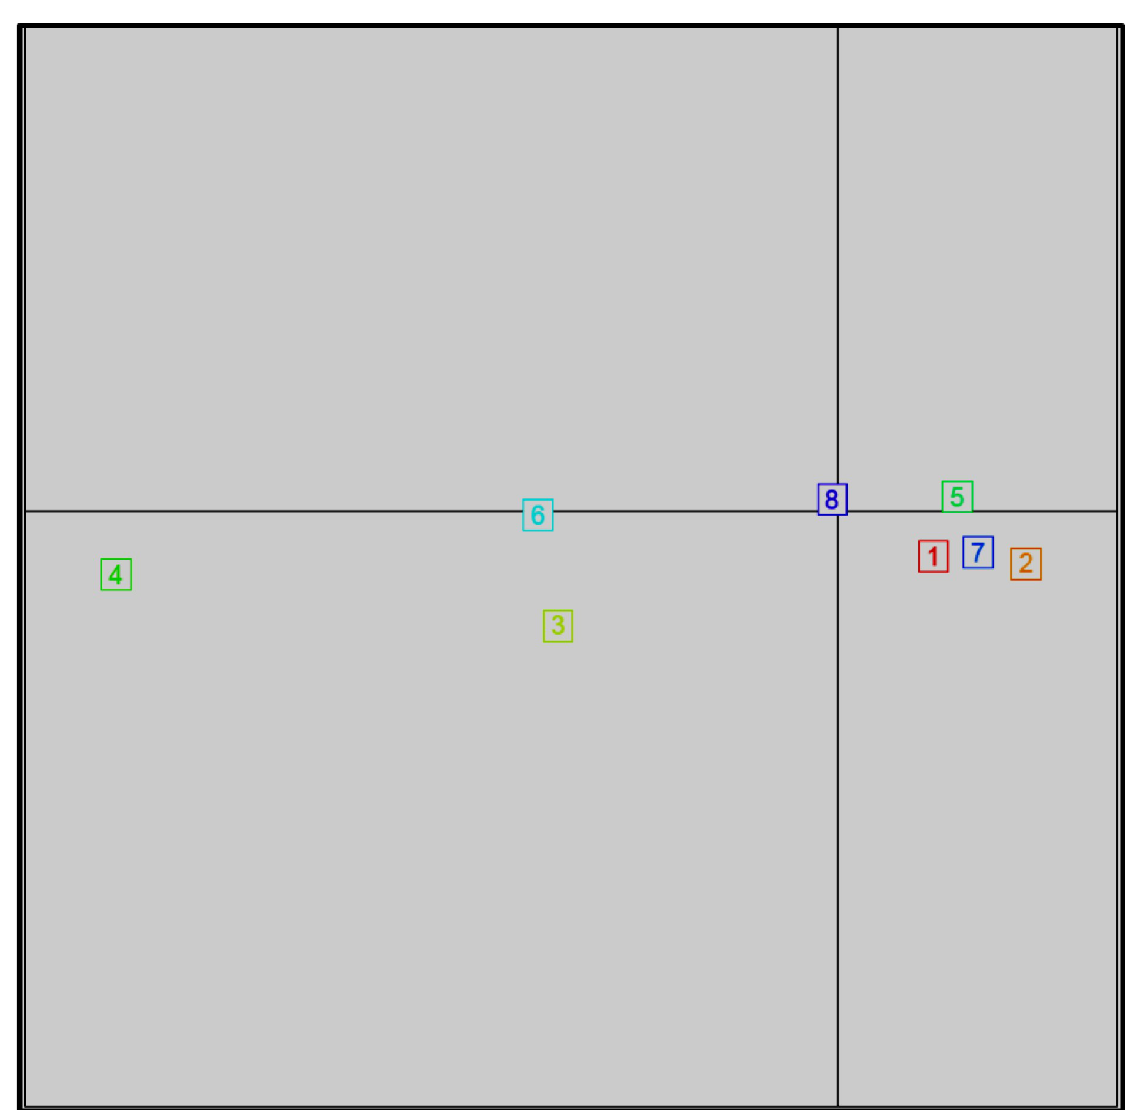
Fig 2. Discriminant analysis of principal components for Fusarium oxysporum f. sp. niveum (FON) from the southeastern United States showing scatterplot of the 8 assigned clusters based on Bayesian information criterion. The four populations include: Berrien County, Georgia (GA1), Cook County, Georgia (GA2), Tift County, Georgia (GA3), and Florida